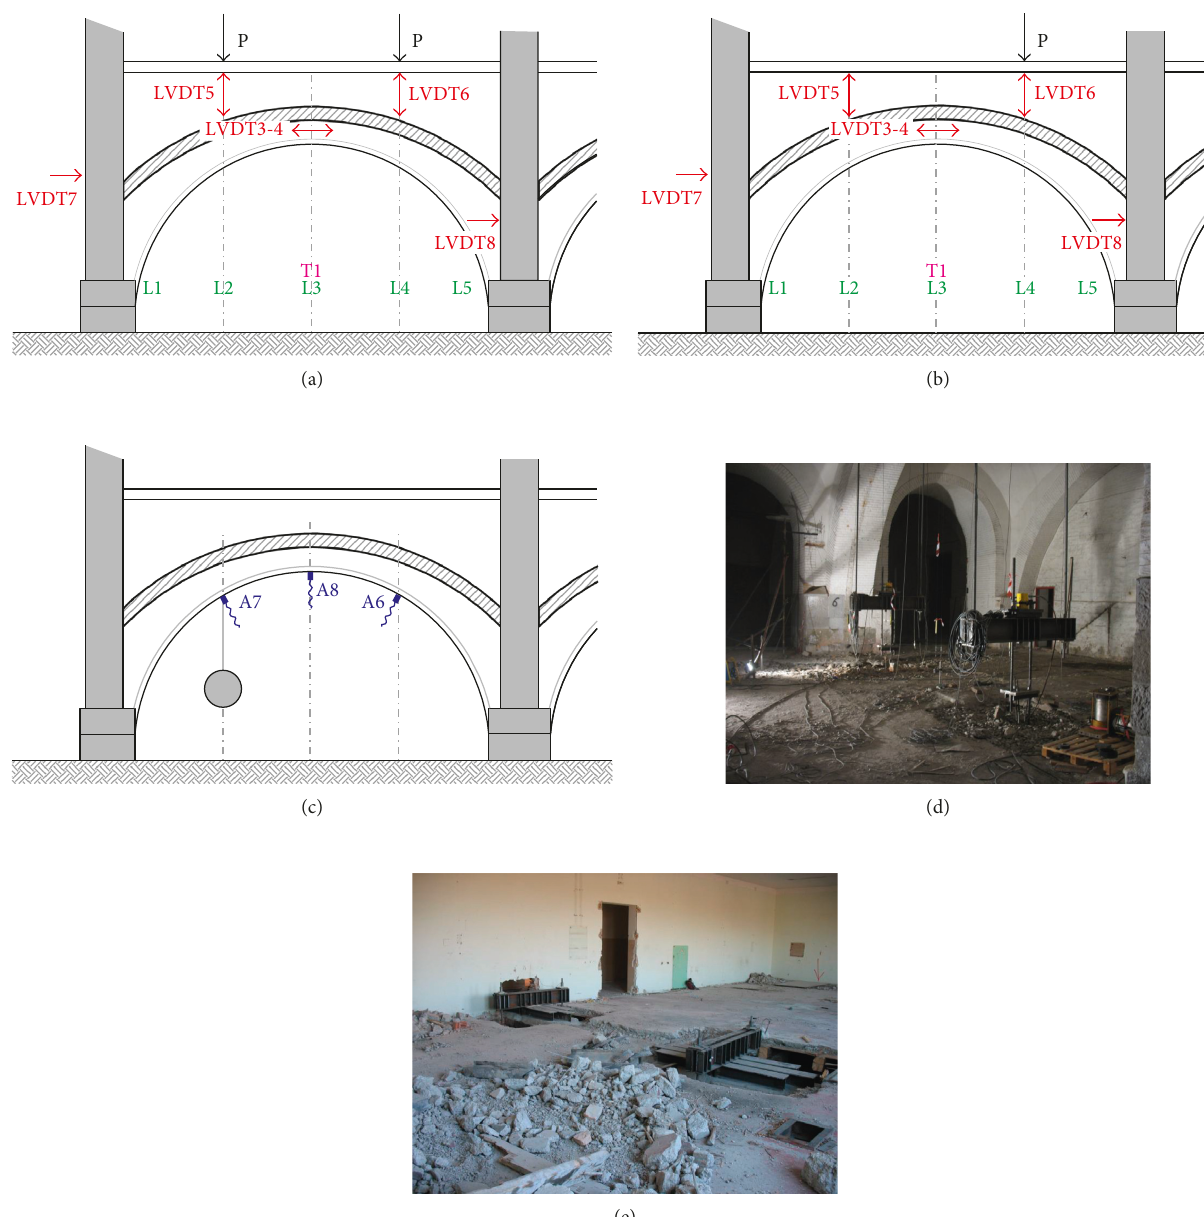
Figure 8: Tests on transverse arches. Instruments adopted during (a) static symmetrical test; (b) static asymmetrical test; (c) dynamic test with weight release; (d) details of the steel frame system adopted for the application of the static load; (e) connection of the system to the